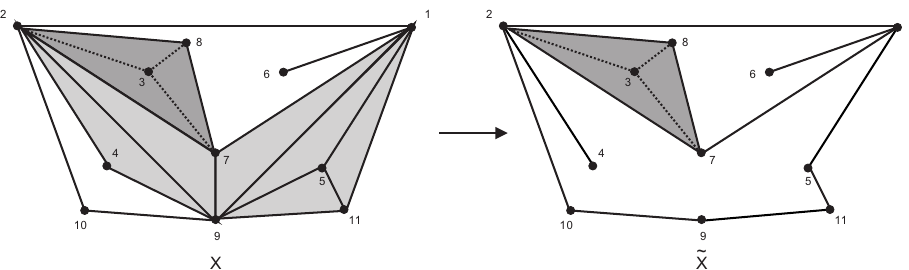
Figure 5. ˜ X is not unique. Performing the following sequence of elementary collapses on the complex X and is displayed in Figure 4; ( { 2,4,9 } , { 4,9 } ) , ( { 2,7,9 } , { 2,9 } ) , ( { 1,7,9 } , { 7,9 } ) , ( { 1,5,9 } , { 1,9 } ) , ( { 1,5,11 } , { 1,11 } ) and ( { 5,9,11 } , { 5,9 } ) produces a different ˜ X .